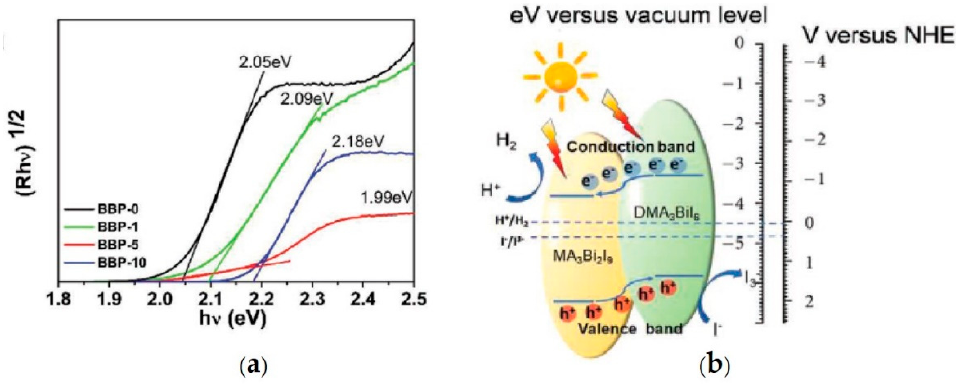
Figure 7. ( a ) Indirect band gap Tauc plot of as synthesized samples; ( b ) Energy level diagram of a MA 3 Bi 2 I 9 /DMA 3 BiI 6 heterojunction for the photocatalytic HI splitting. Reproduced from [78], with permission from Wiley,